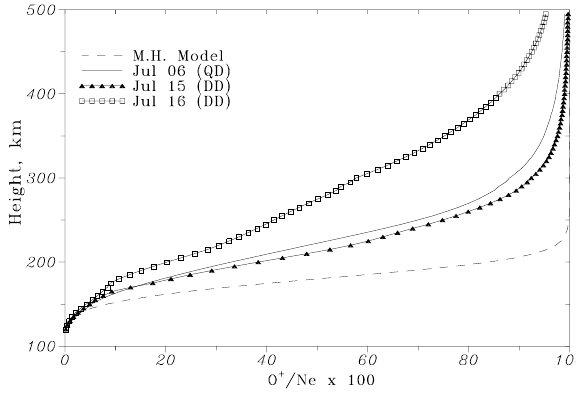
Fig. 7. Calculated O + / Ne ratio for the 15–16 July 2000 storm com- pared to the Millstone Hill model. Note that the quiet time ion com- position also strongly differs from the model